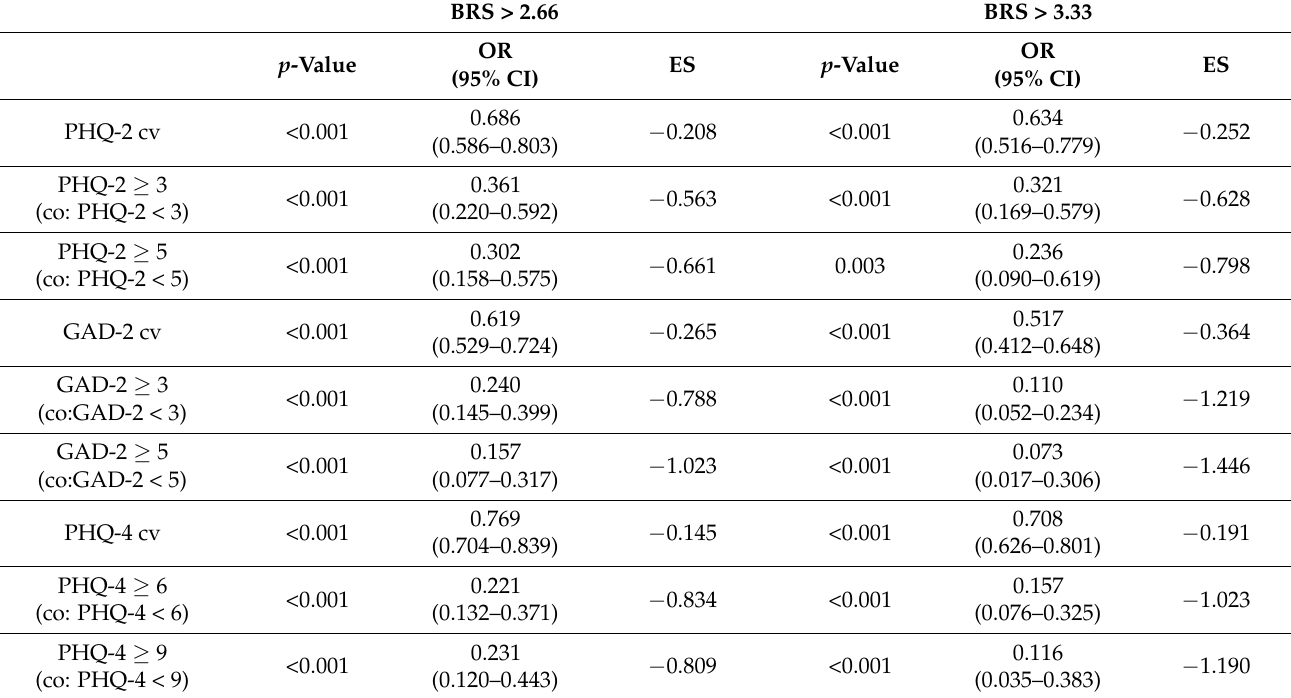
Table 7. Effect of mental health on resilience (univariate logistic regression analysis). BRS > 2.66 BRS >